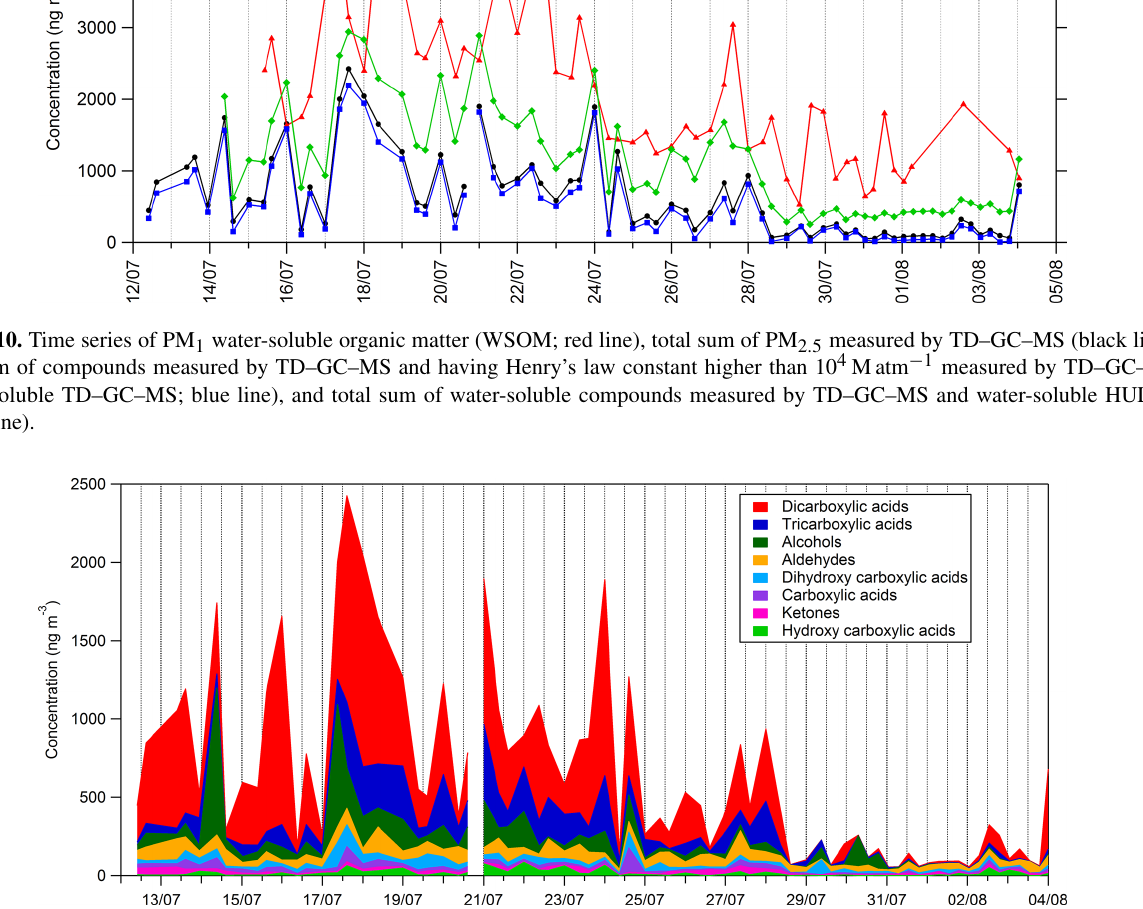
Figure 11. Time series of the composition of the sum of all compound concentrations measured by